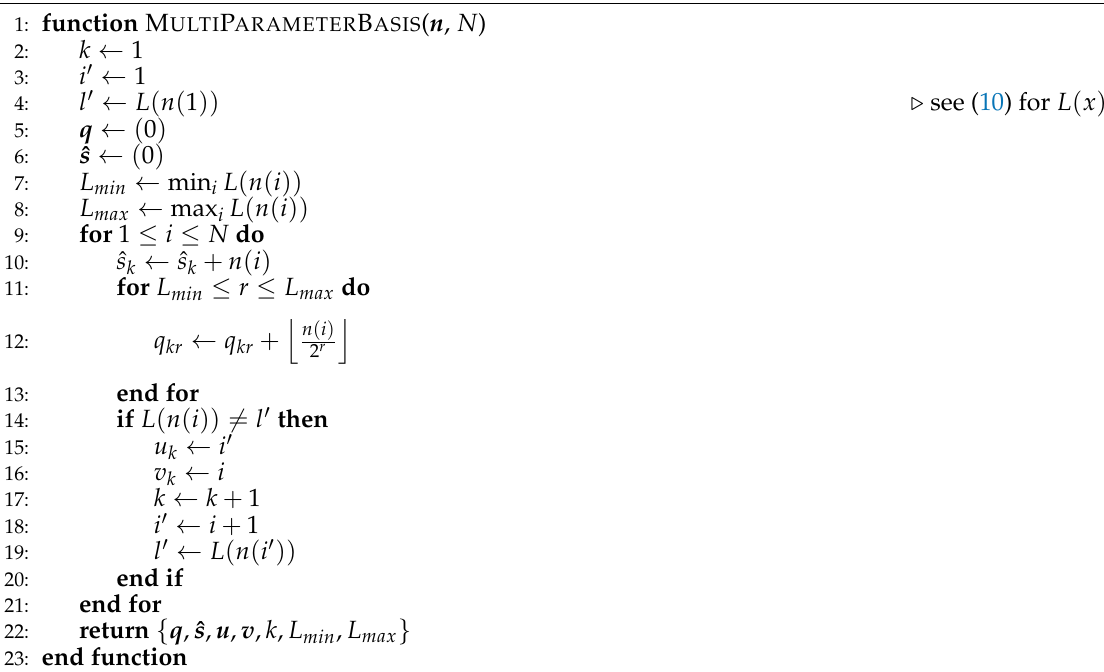
Algorithm 2 Calculation of the basis for the multi-parameter Rice-encoding problem with complexity O ( L max · N ) .